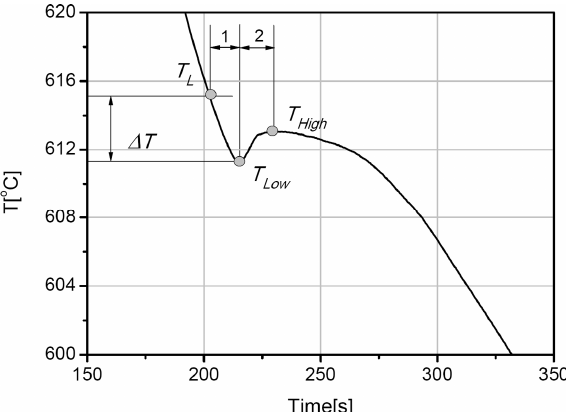
Figure 7. Schematic view of a cooling curve during the initial solidification. T L : liquidus of sample, T Low : lowest point before recalescence, T High : highest point after recalescence, Δ T : maximum undercooling, 1: nucleation period, 2: recalescence period.